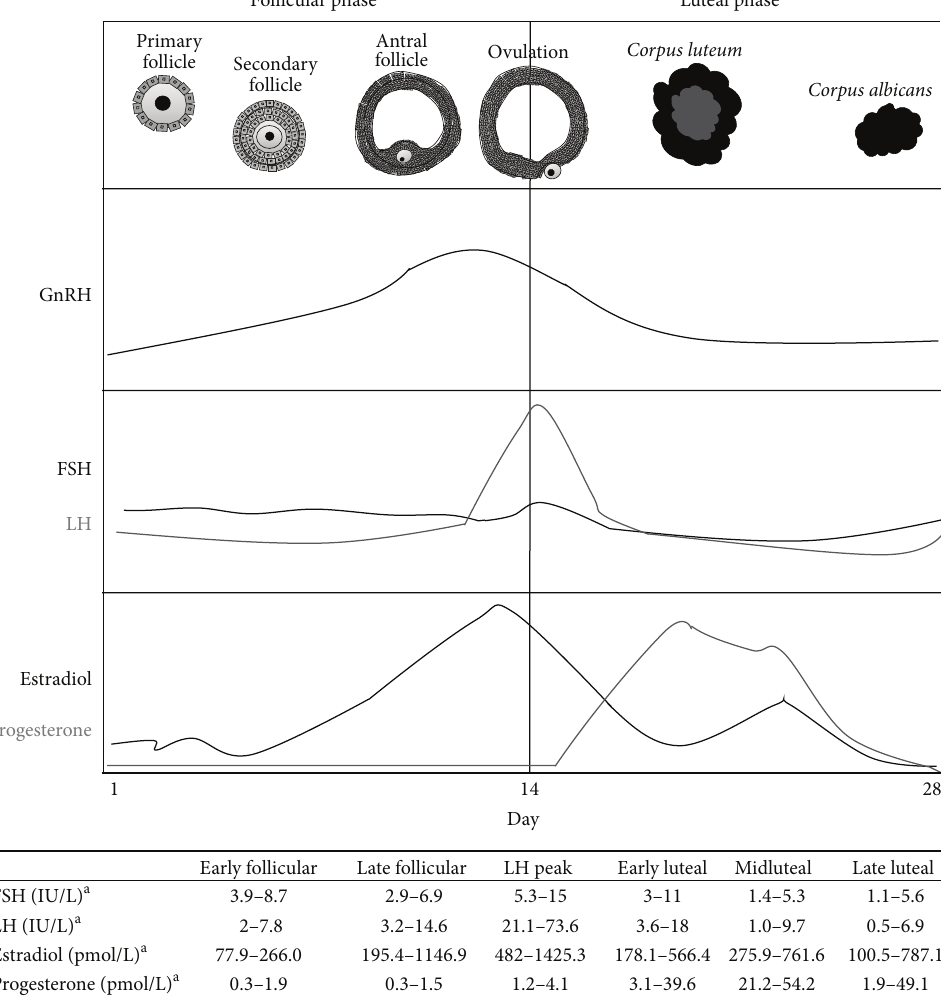
Figure 6: Evolution of the ovarian follicle and hormonal levels throughout the ovarian cycle. FSH: Follicle-Stimulating Hormone; GnRH: Gonadotropin-ReleasingHormone;LH:luteinizinghormone. a Strickeretal.[151].Thefirstdayoftheovariancycle,GnRHlevelscommencea progressive rise, which is accompanied by FSH and, to a lesser extent, LH secretion. Ovarian stimulation by gonadotropins leads to a gradual increase in estradiol levels, which towards midcycle induce a LH peak. This LH acme triggers ovulation and thus begins formation of the corpus luteum . This tissue will then progressively achieve a peak in progesterone secretion and then gradually decline as gonadotropin levels drop and the corpus luteum degenerates into the corpus albicans, marking the end of the luteal phase, and the beginning of a new